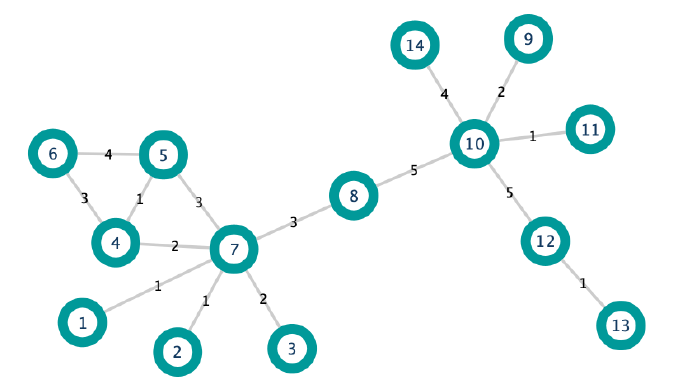
Figure 1. Simple